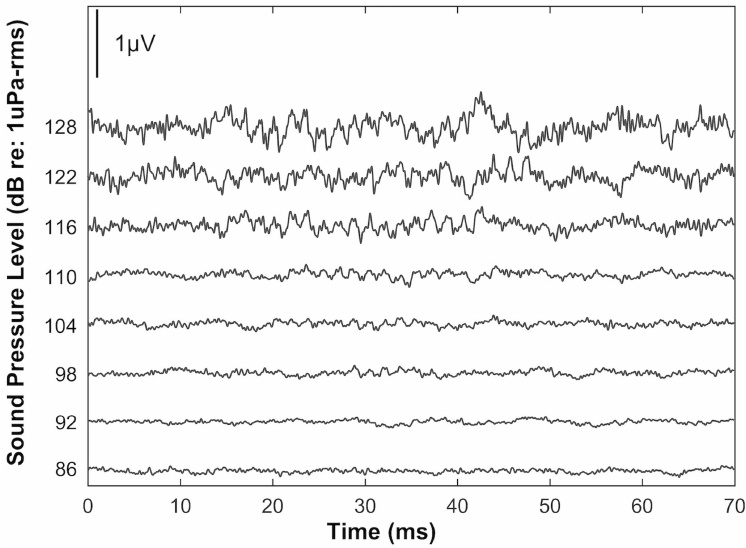
Fig 1. Underwater auditory evoked potential waveformsrecorded from a juvenile green sea turtle ( Chelonia mydas , L4), and corresponding stimuli levels in responseto an underwater signal of 300